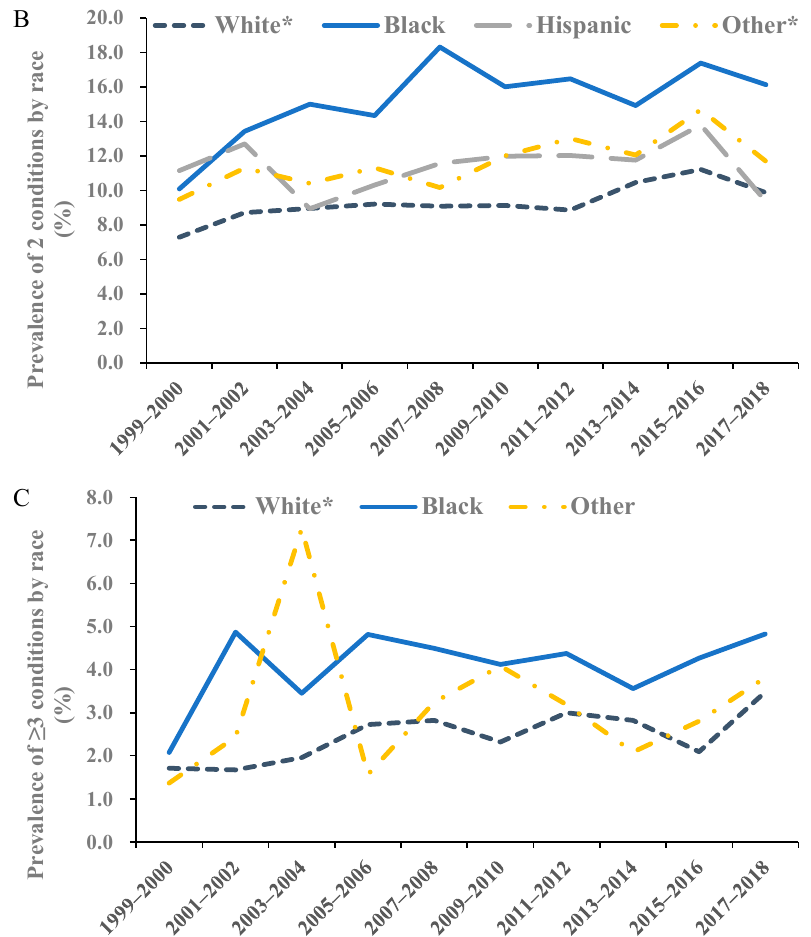
Figure 3. Trends in the age-adjusted prevalence of cardiometabolic multimorbidity by race/ethnicity among U.S. adults, 1999–2018. Notes: The averaged trends were estimated with AAPC derived from joinpoint regression models. Panel ( A ): For CMM overall by race/ethnicity; Panel ( B ): For two concurrent cardiometabolic diseases by race/ethnicity; Panel ( C ): For ≥ three concurrent cardiometabolic diseases by race/ethnicity. The prevalence of Hispanic subgroup for ≥ three conditions during 1999– 2018 was too low to be estimated, which hindered the estimation of AAPC with joinpoint regression models, so the related trend is not shown in the figure. CMM, cardiometabolic multimorbidity; AAPC, averaged two-year cycle percentage change. * p for trend <0.05.